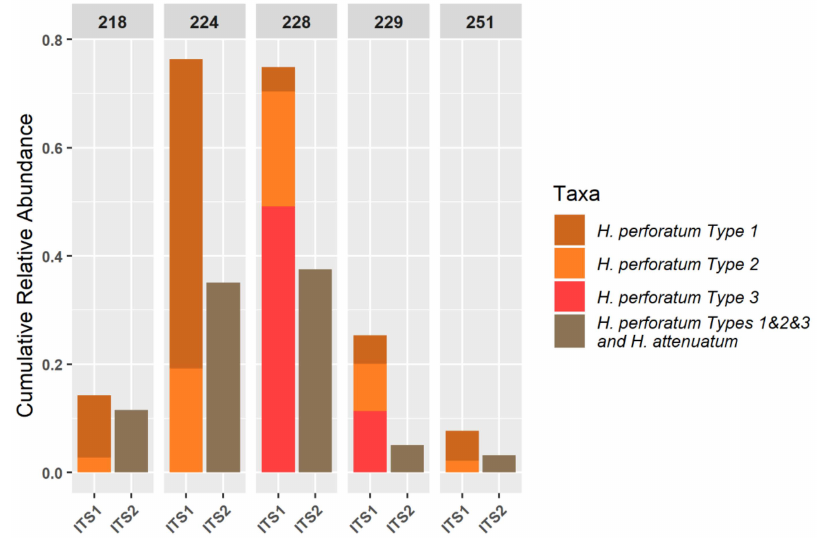
Figure 6. Taxonomic profiles of the clusters queried to the local Hypericum database. Only sequence clusters that matched genus Hypericum in the NCBI BLAST were used to further investigate the species